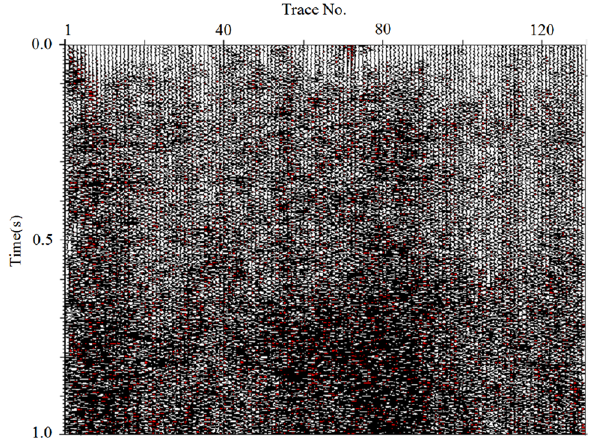
Fig. 10 Removed random noise. It is the difference plot between Figs. 4 and 9. No loss of geological information